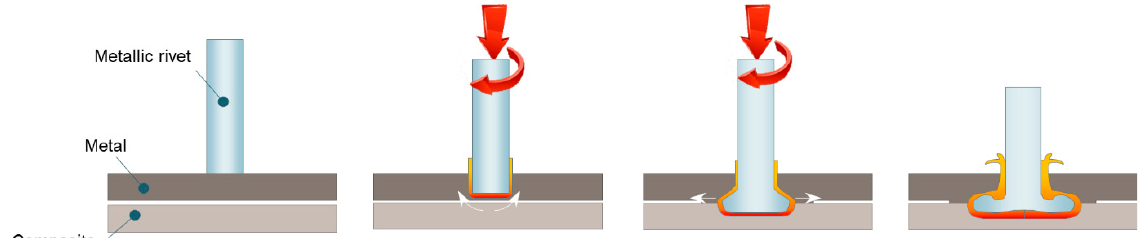
Figure 9. Schematic of the friction riveting process.